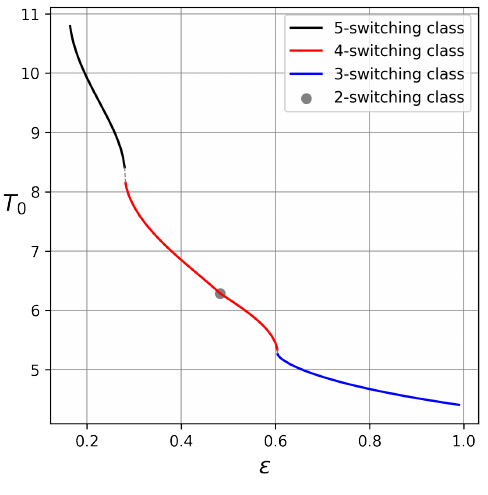
Figure 5. Dependence T 0 ( ε )